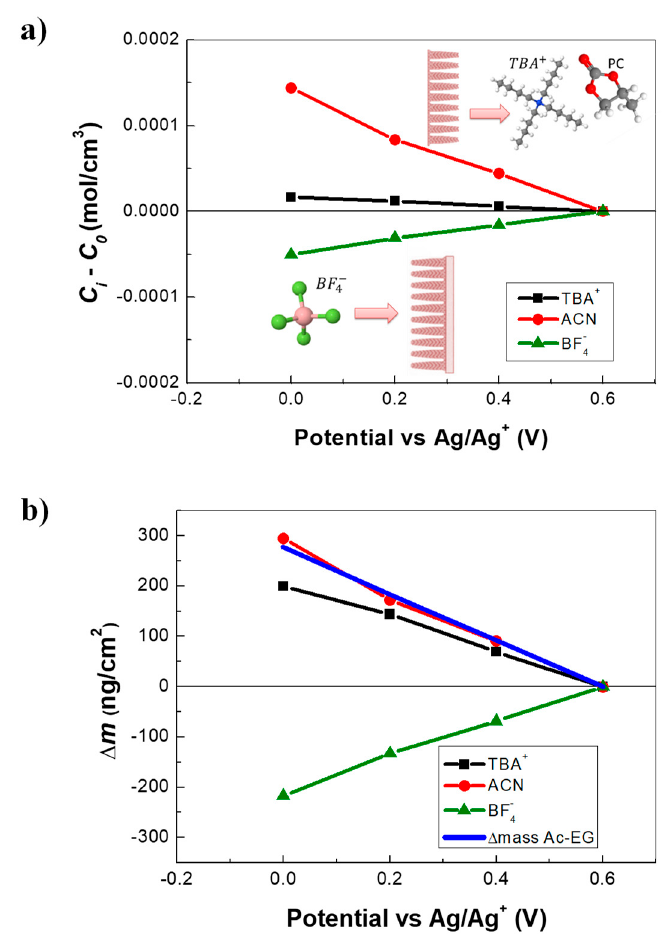
Figure 3. Complementary EQCM and ac –electrogravimetry (AC–EG) results of PEDOT NWs: ( a ) The variation of the relative concentration ( Ci − C 0 ) and ( b ) the relative mass variation of each species measured in ACN + 0.5M TBABF 4 . The reconstruction of total mass variation from AC–EG (in 0.6–0 V vs. Ag/Ag + region).